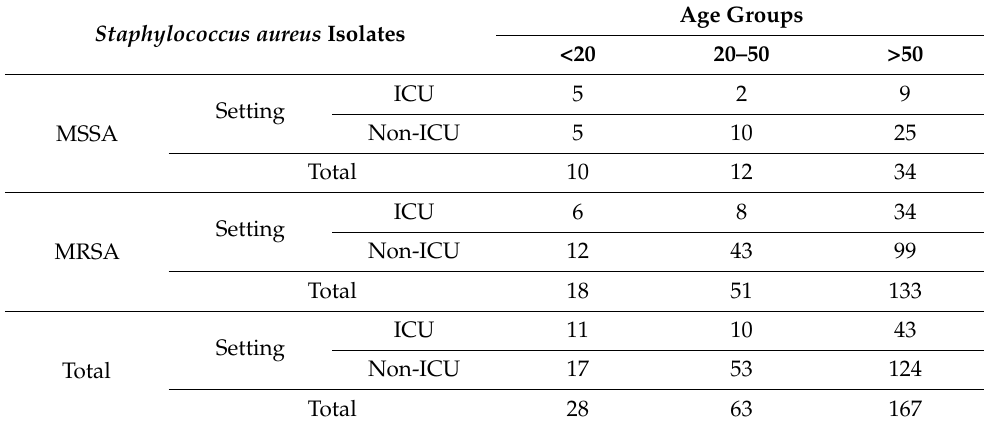
Table 1. Profiles of nosocomial MRSA and MSSA clinical isolates among different age-groups of patients at ICUs, and other non-ICUs settings in Ha’il region, Saudi Arabia. Age Groups Staphylococcus aureus Isolates <20 20–50 >50 ICU 5 2 9 Setting Non-ICU 5 10 25 MSSA Total 10 12 34 ICU 6 8 34 Setting Non-ICU 12 43 99 MRSA Total 18 51 133 ICU 11 10 43 Setting Non-ICU 17 53 124 Total Total 28 63